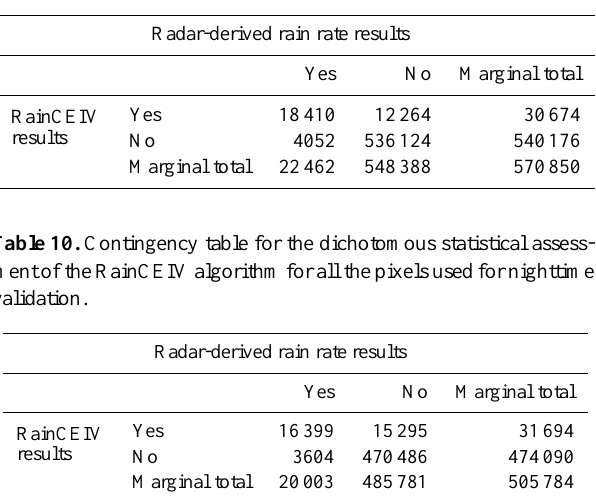
Table 9. Contingency table for the dichotomous statistical assess- ment of the RainCEIV algorithm for all the pixels used for daytime validation.